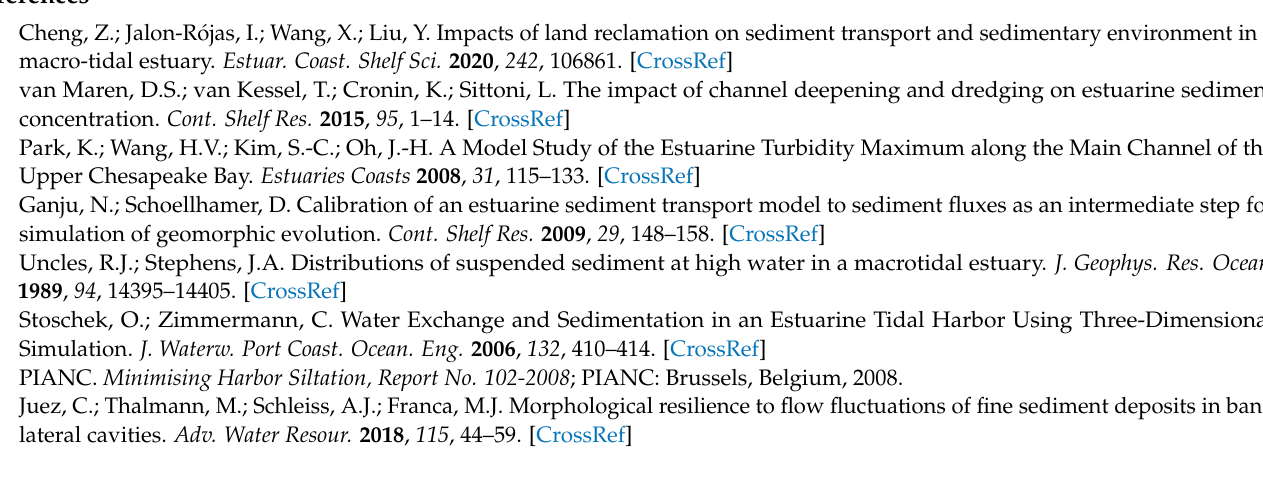
Figure A1. ( a ) Unstructured computational grid for Gyeonggi Bay; and ( b ) grid near the North Port.